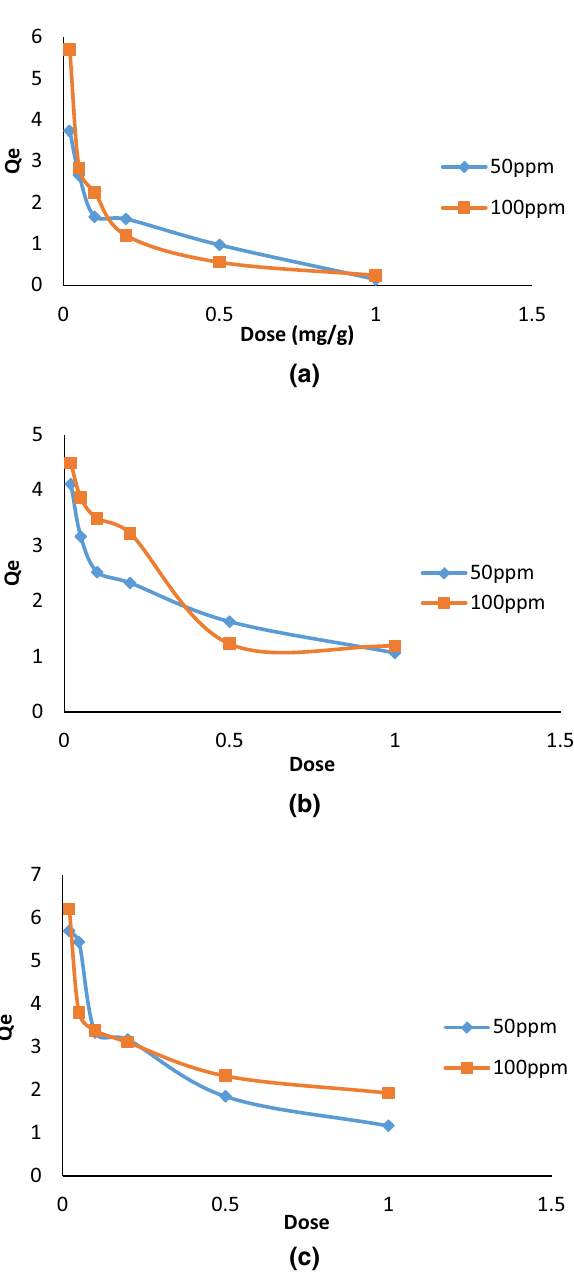
Fig. 5 a Dose profile diagram for C(VI)// a G and C(VI)// b G system, b dose profile diagram for Cr(VI)// a AC and Cr(VI)// b AC system, c dose profile diagram for Cr(VI)// a GAC and Cr(VI)// b GAC